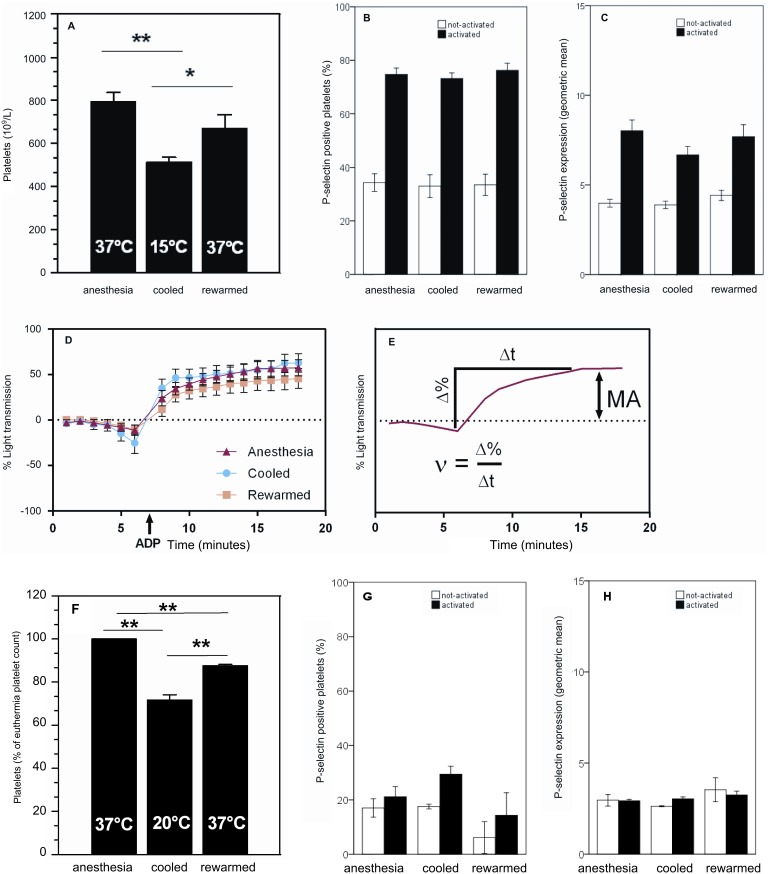
Decreased platelet count with preserved function during forced hypothermia.A) Rats forced to hypothermia of 15°C have a decreased amount of platelets, which partially restores during rewarming. B) No difference in amount of activatable platelets from anestethized euthermic, cooled or rewarmed rats. C) Unchanged P-selectin expression at all time points in both non-activated and activated whole blood samples. D) Unchanged aggregometry at all time points upon addition of ADP. E) Mathematical approach for velocity and max amplitude of platelet aggregation. ν, velocity of aggregation; Δ%, change in percentage light transmission; Δt, timespan over which velocity is determined; MA, maximum aggregation in % light transmission. F) Mice forced to hypothermia of 20°C have a decreased amount of platelets, which partially restores during rewarming. Panels G) and H) show unchanged platelet P-selectin expression between time points in non-activated and activated whole blood samples. Bars represent mean ± SEM of 7 to 27 rats per group and 3 to 9 mice per group. *P<0.05, **P<0.01.